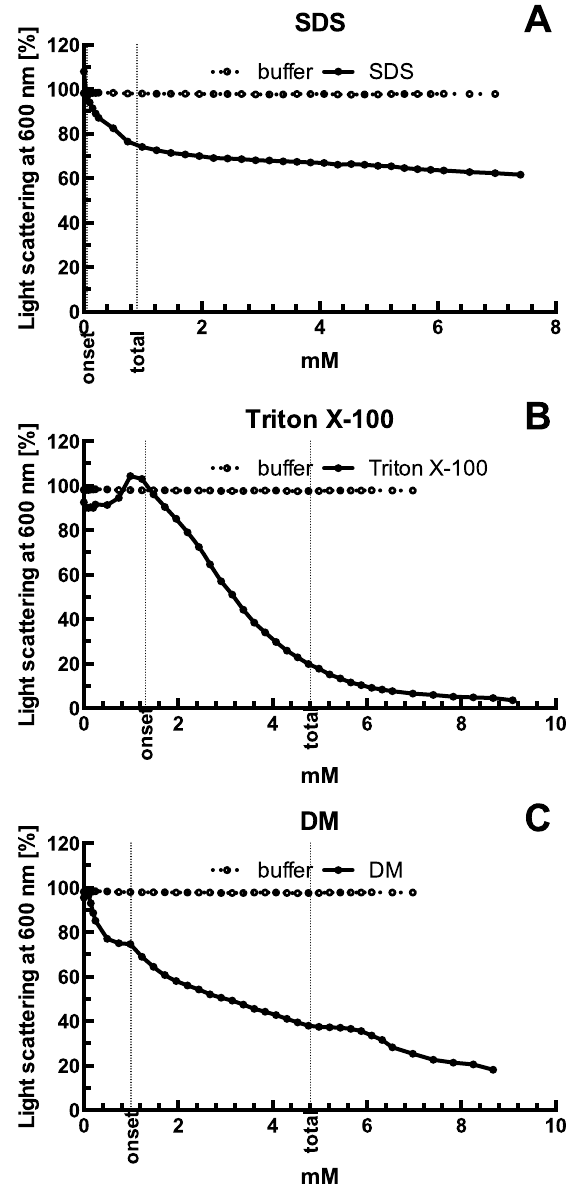
Figure 2. Solubilization of liposomes (black circles) by SDS (A), Triton X-100 (B) and DM (C) monitored by light scattering. The onset of solubilization concentration and the total lysis concentration are marked with dashed lines. As a control, a buffer without detergent (empty circles) was titrated into liposomes.